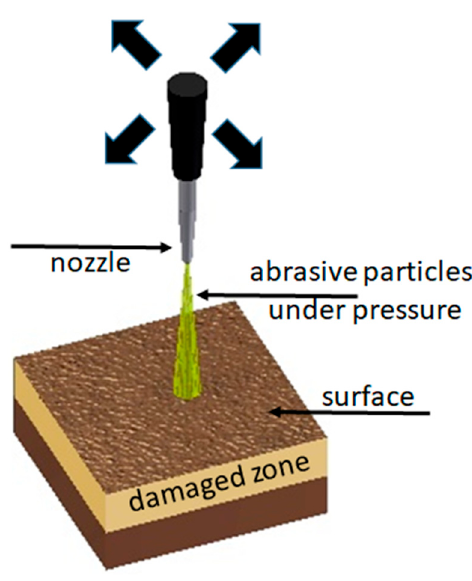
Figure 1. The scheme of the sandblasting procedure of the studied samples.